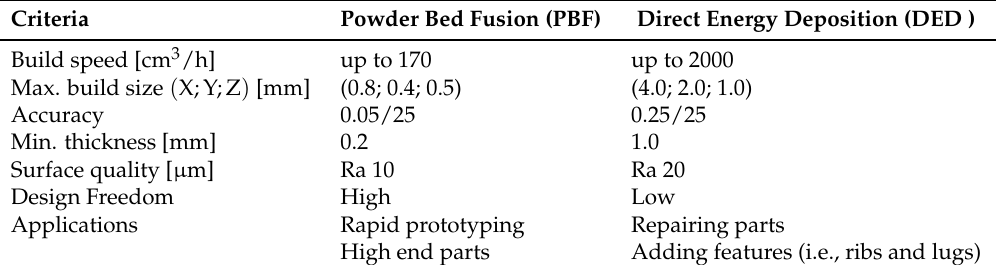
Figure 2. General working principle of PBF and DED categories [25,26]. Table 1. General comparison of PBF and DED